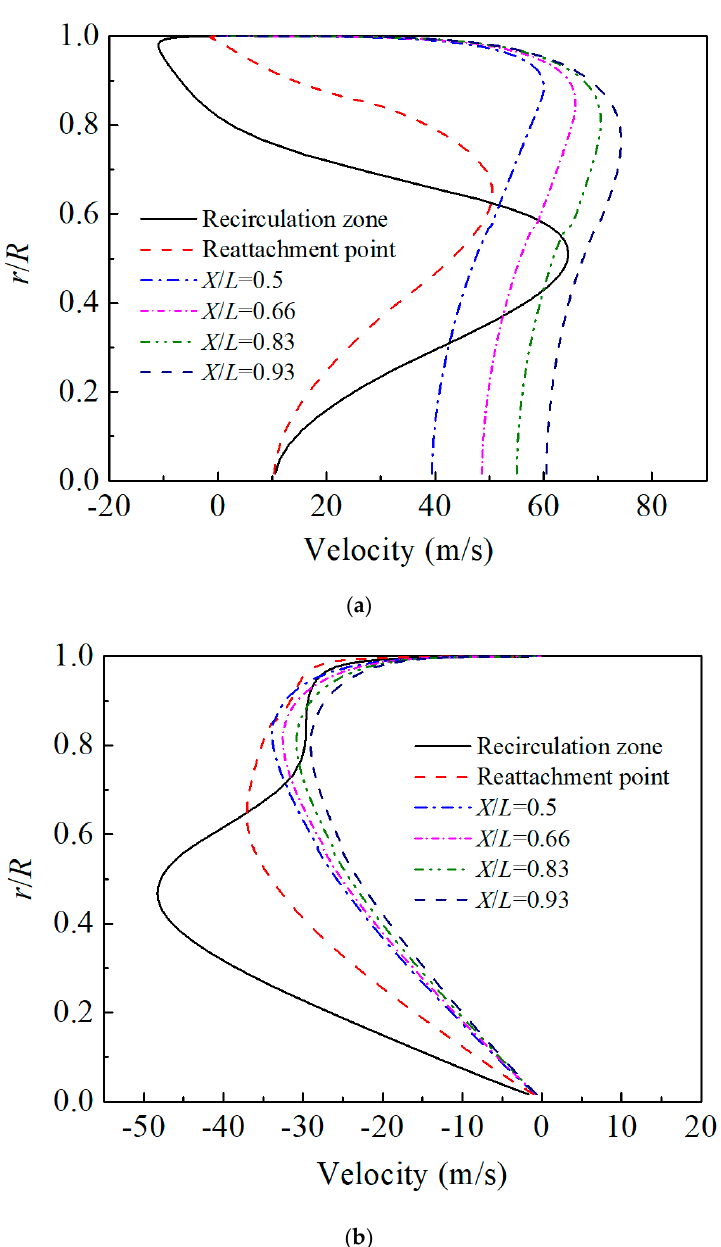
Figure 18. Radial profiles of axial ( a ) and tangential velocity ( b ) at different axial positions along the